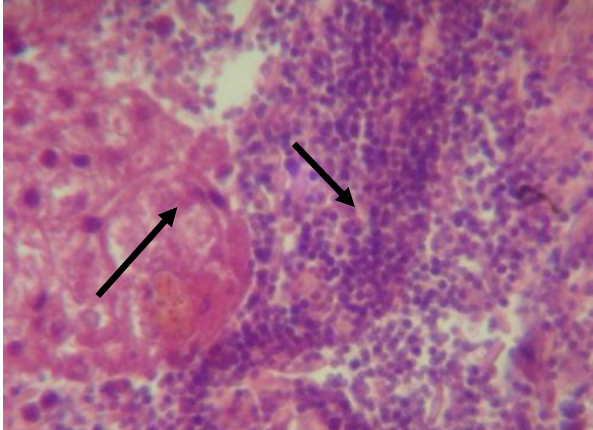
Figure3: Histopathological section of liver 14 - day post infection show inflammatory exudate that consists mainly of PMNCS and fibrinus deposit (H&E40×).